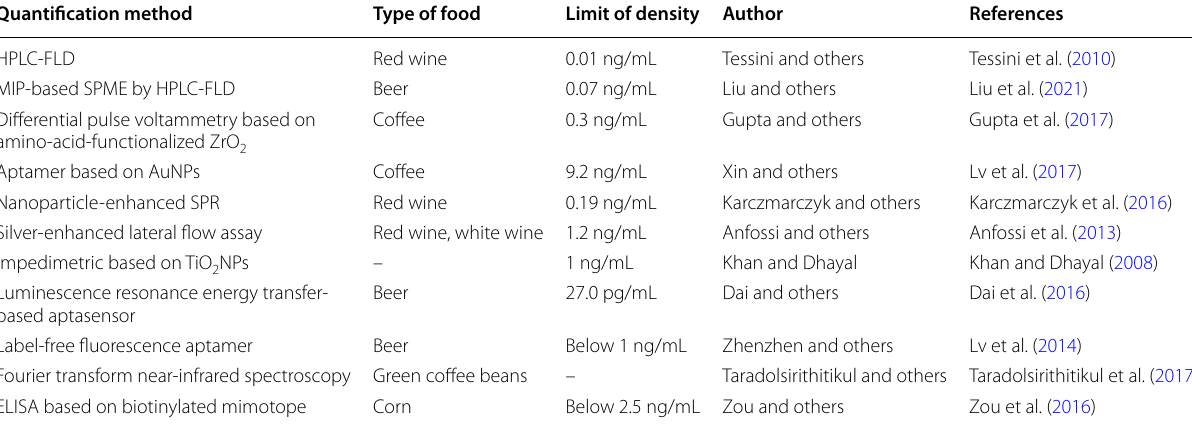
Table 1 Comparison of analytical methods for the detection of